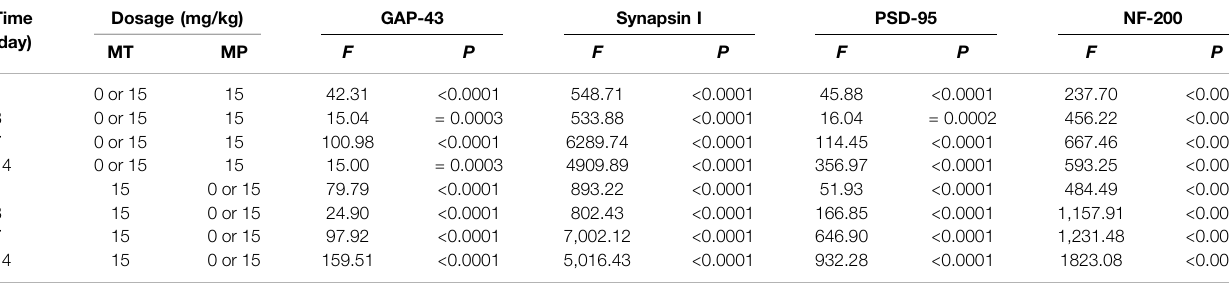
TABLE 4 | Simple effects results of ANOVA of neurocritical proteins in rats.